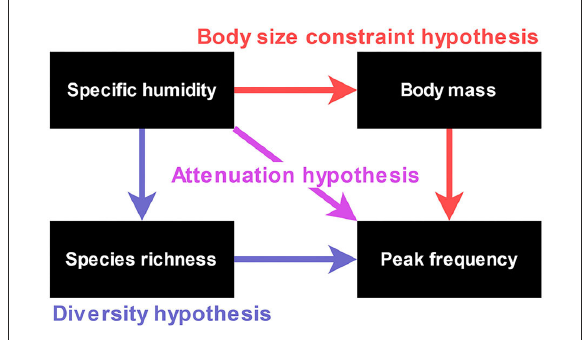
FIGURE3 A schematic path diagram showing the variables and direct and indirect effects in the model: The effects corresponding to each of the three hypotheses are shown in different colors.